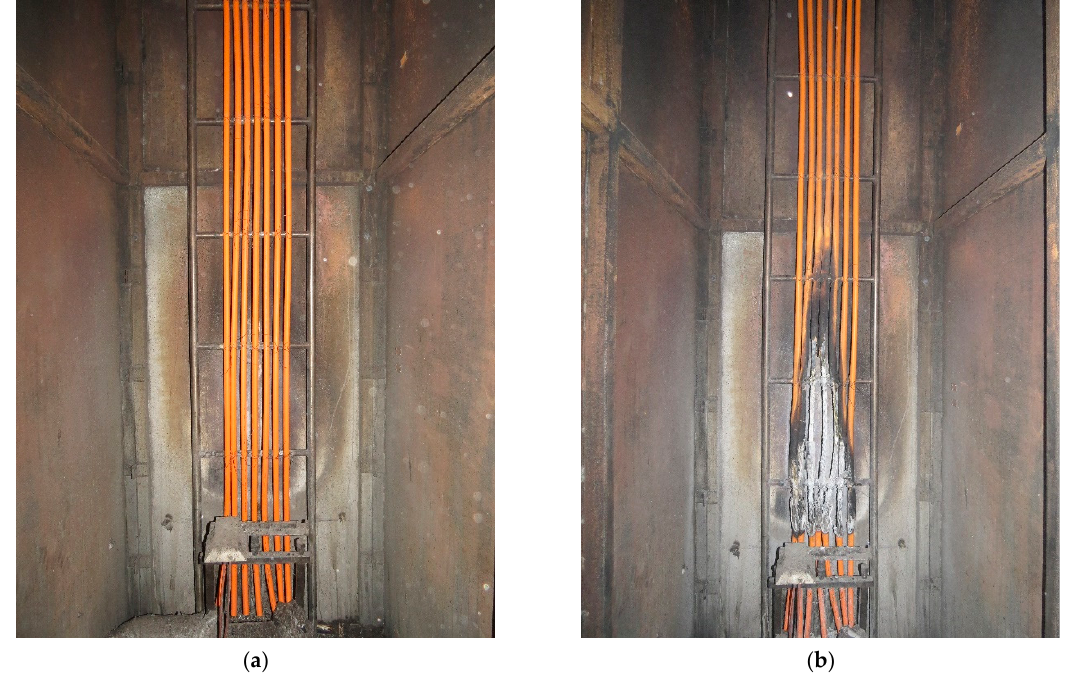
Figure 3. Cable sample No 3 installed on the test ladder: ( a ) before the test, ( b ) after the test.